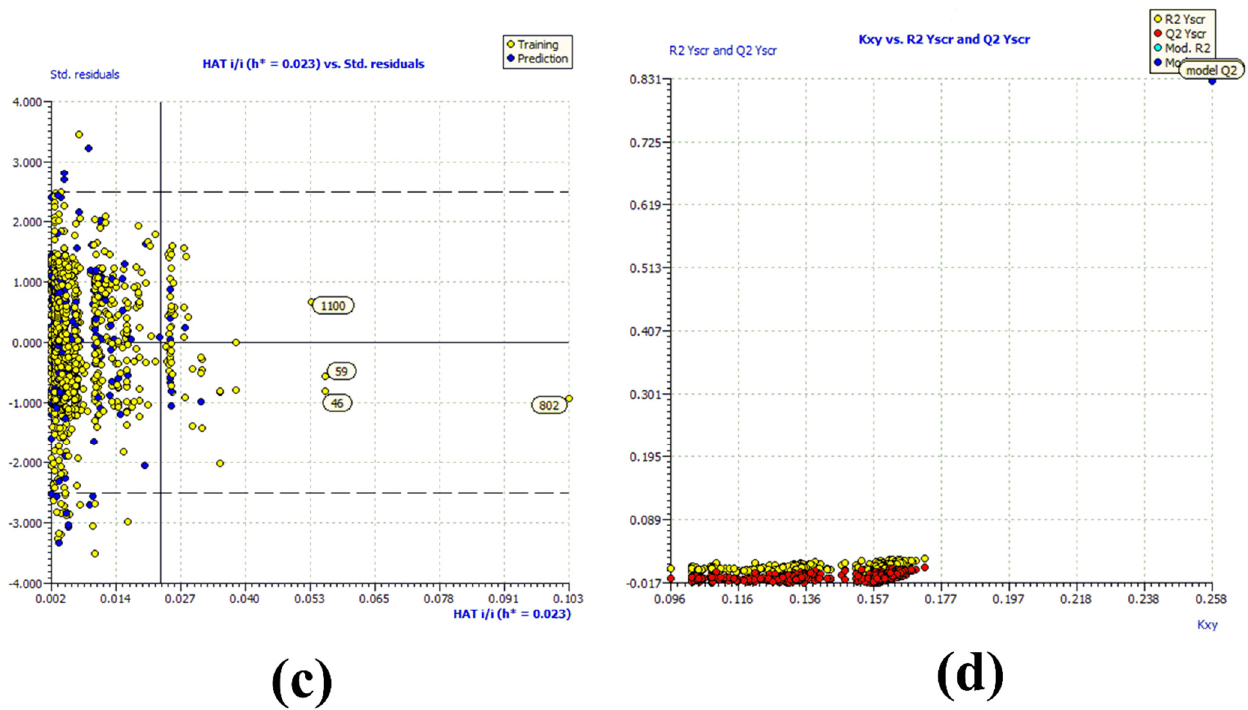
Figure 3. Graph for ( a ) experimental vs. predicted pKi (the solid line represents the regression line); ( b ) experimental vs. residuals; ( c ) Williams plot for applicability domain (the vertical solid line represents h* = 0.023 and horizontal dashed lines represent the upper and lower boundaries for applicability domain); ( d ) Y-randomization.